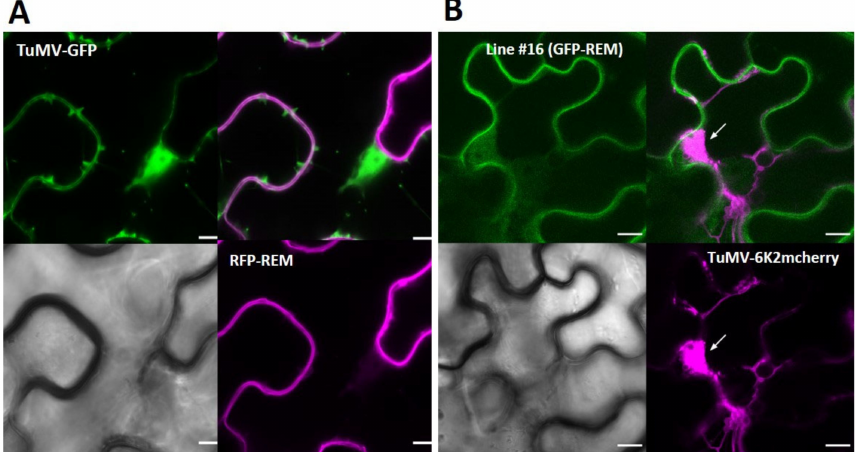
Figure 6. TuMV infection does not modify StREM1.3 plasma membrane localisation: ( A ) transient expression of RFP–StREM1.3. Representative confocal images showing the membranous transiently expressed RFP–StREM1.3 in N. benthamiana leaf epidermal cells infected by TuMV–GFP at 5 dpi. RFP–StREM1.3 remains membranous; ( B ) stable overexpression of GFP–StREM1.3. Representative confocal images showing the membranous expressed GFP–StREM1.3 in the overexpressing transgenic line #16 during TuMV-6K2mcherry infection at 5 dpi. The red signal labels the 6K2-induced vesicles and the viral replication complex (VRC) near the nucleus as indicated by the white arrow. Scale bar = 10 µ